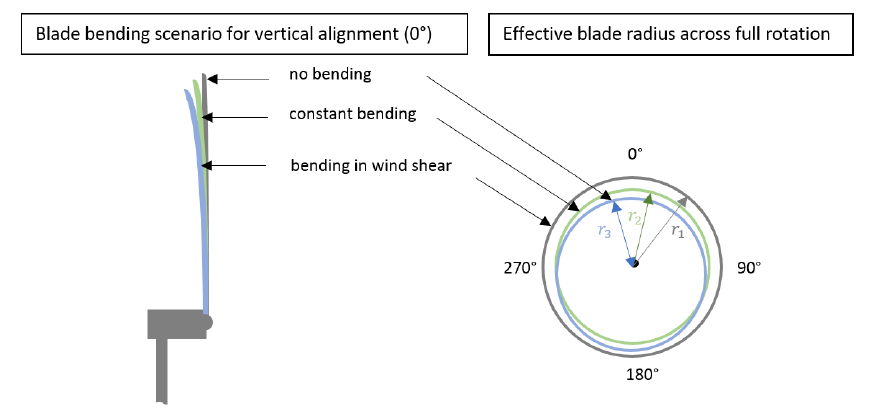
Figure 1. Sketch of blade bending for (i) no bending, (ii) constant bending, and (iii) bending due to wind shear: visualisation of blade bending ( left ) and effective blade radius across rotation ( right